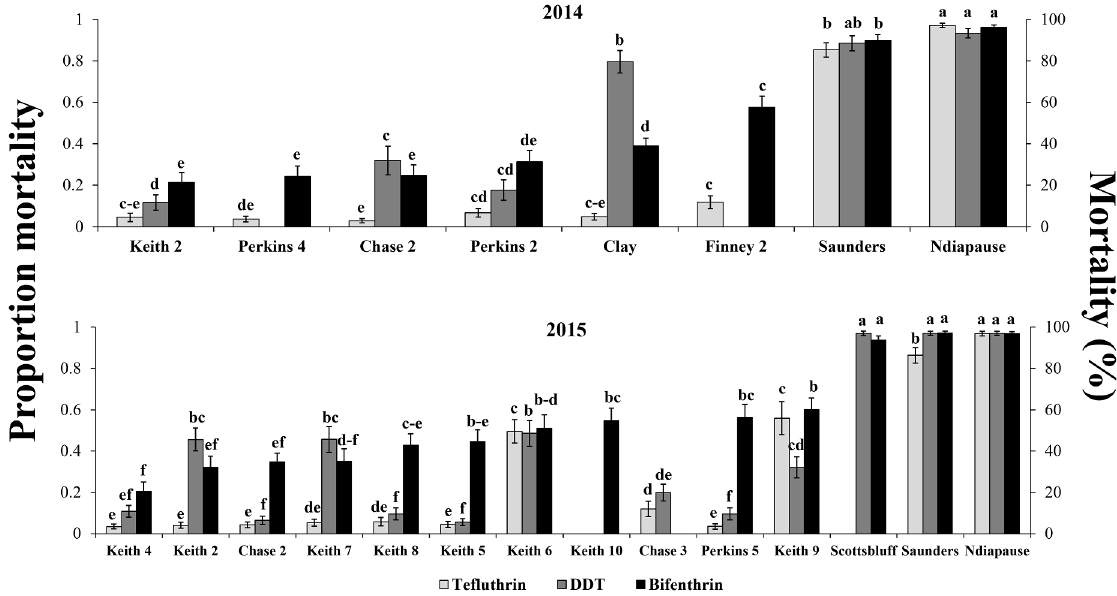
Fig 2. Mean proportion western corn rootworm adult mortality ( ± SE) at diagnostic concentration (LC 99 ) of field populations and a susceptible non-diapause population in 2014 and 2015bioassays for the insecticides bifenthrin, tefluthrin, and DDT. N = at least 10 reps of 10 beetlesper bioassay; LC 99 : Bifenthrin= 0.77 μ g/vial; Tefluthrin = 0.60 μ g/vial; DDT = 6.02 μ g/vial.Within insecticides, means with the same letter above bars are not significantly different (LSmeans test, p > 0.05).Bifenthrindata for 2014 taken from Pereiraet al. (2015).